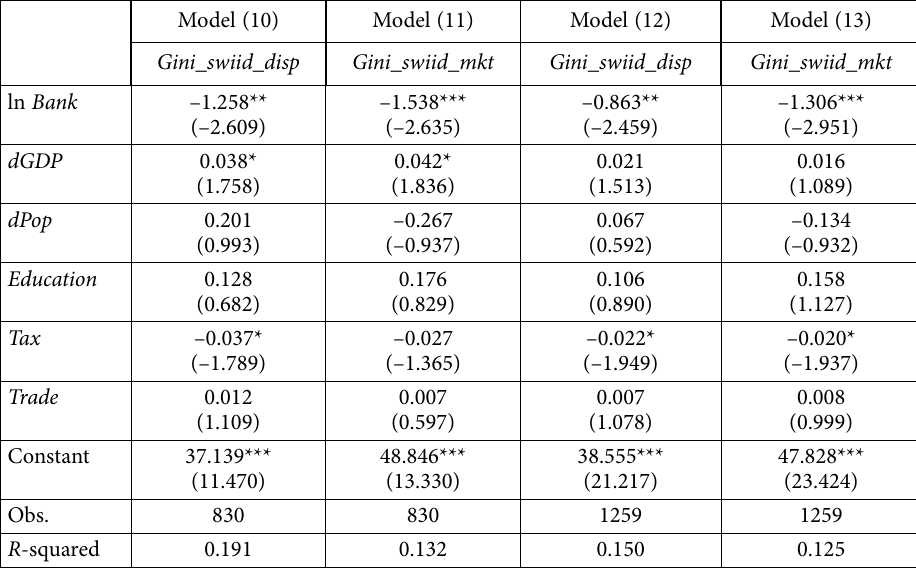
Table 4. Results of the robustness test (using the Gini coefficient from